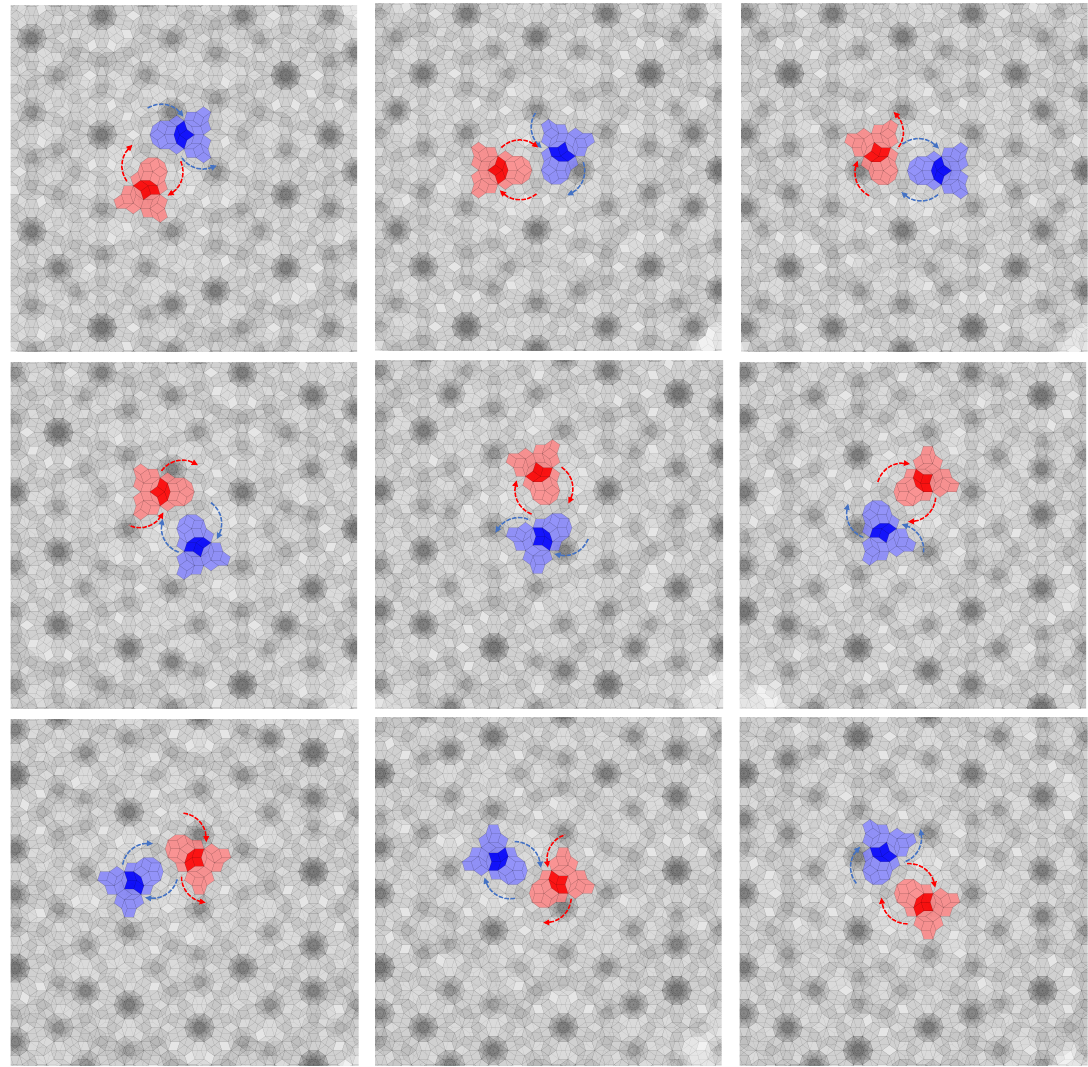
Figure 7. Illustration of the stabilized pattern for one type of interaction between two